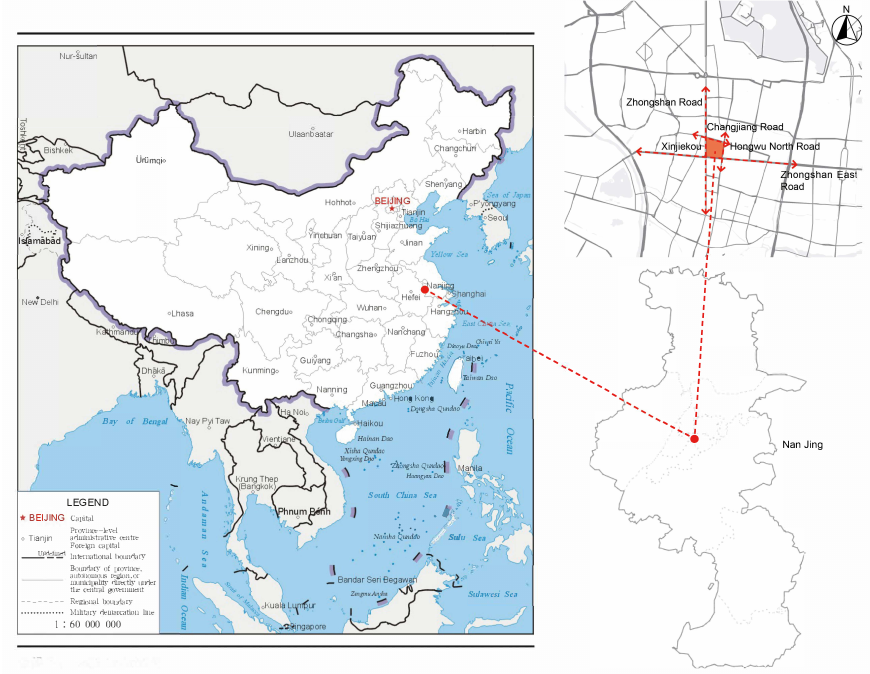
Figure 1. The site is located in north of Xinjiekou which is the central city of Nanjing, Jiangsu Province, China. (Left, China Standard Map from http://bzdt.ch.mnr.gov.cn/, accessed on 25 June 2022).